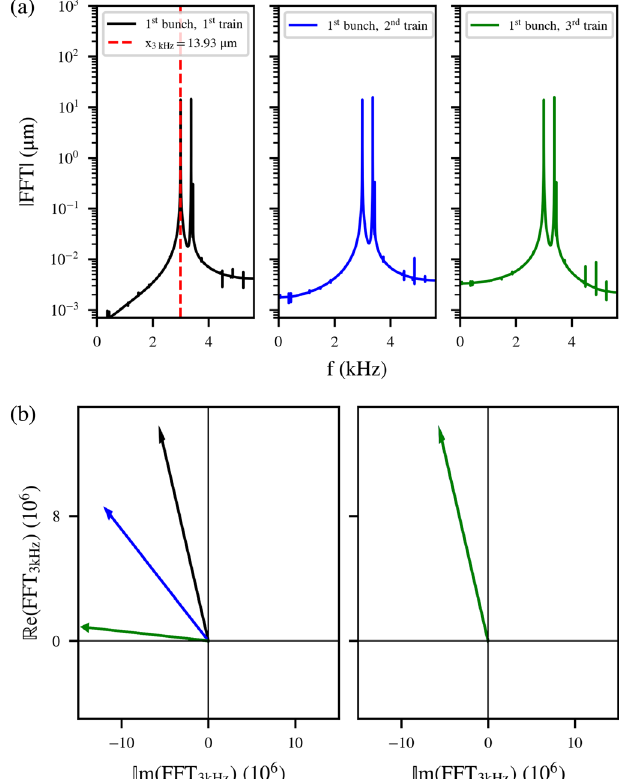
FIG. 22. (a) Spectrum of the first bunches of the first (black), second (blue), and third (green) train in the presence of a dipolar excitation at 3 kHz (red dashed line). (b) Phase of the excitation for the three bunches before (left) and after (right) the correction as computed from Eq.